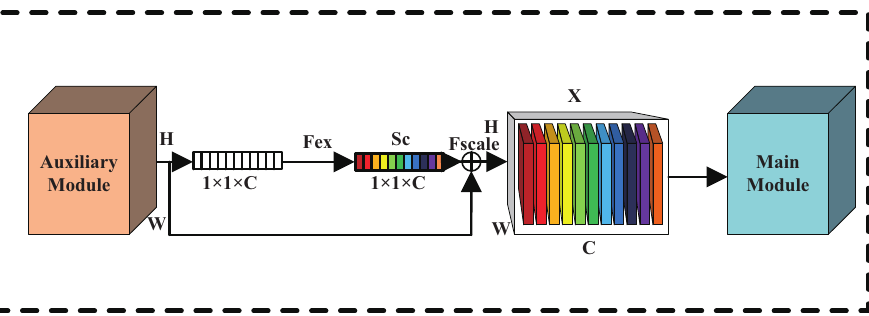
Figure 11. The squeeze excitation module improves the ability to increase learning by squeezing and motivating.